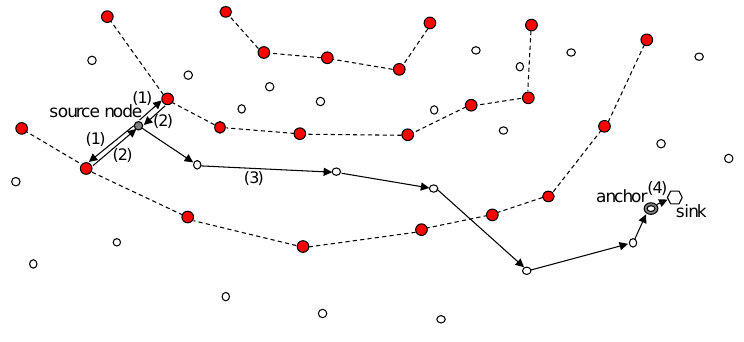
Figure 9. Request of anchor node’s position and data